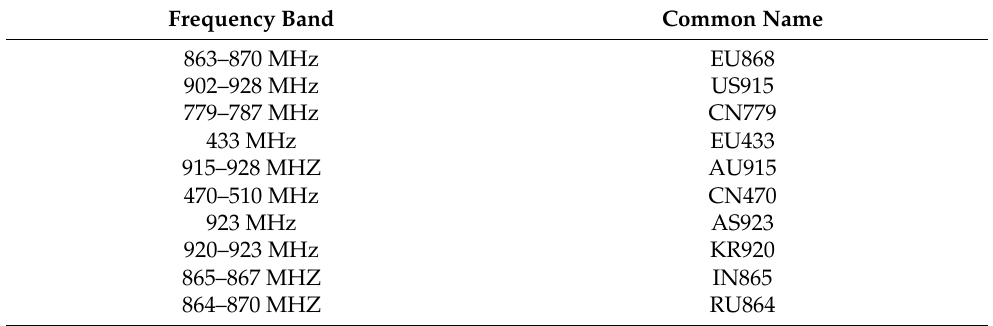
Table 1. Frequency bands. Frequency Band Common